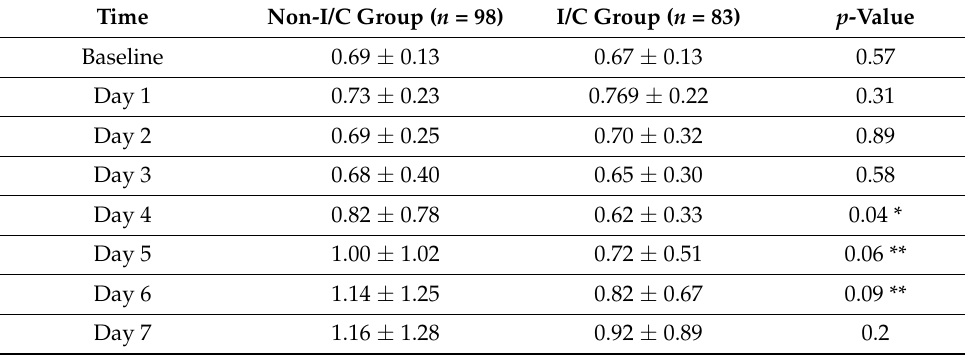
Table 2. Serum creatinine levels (mg/dL) from baseline up to day 7. Time Baseline